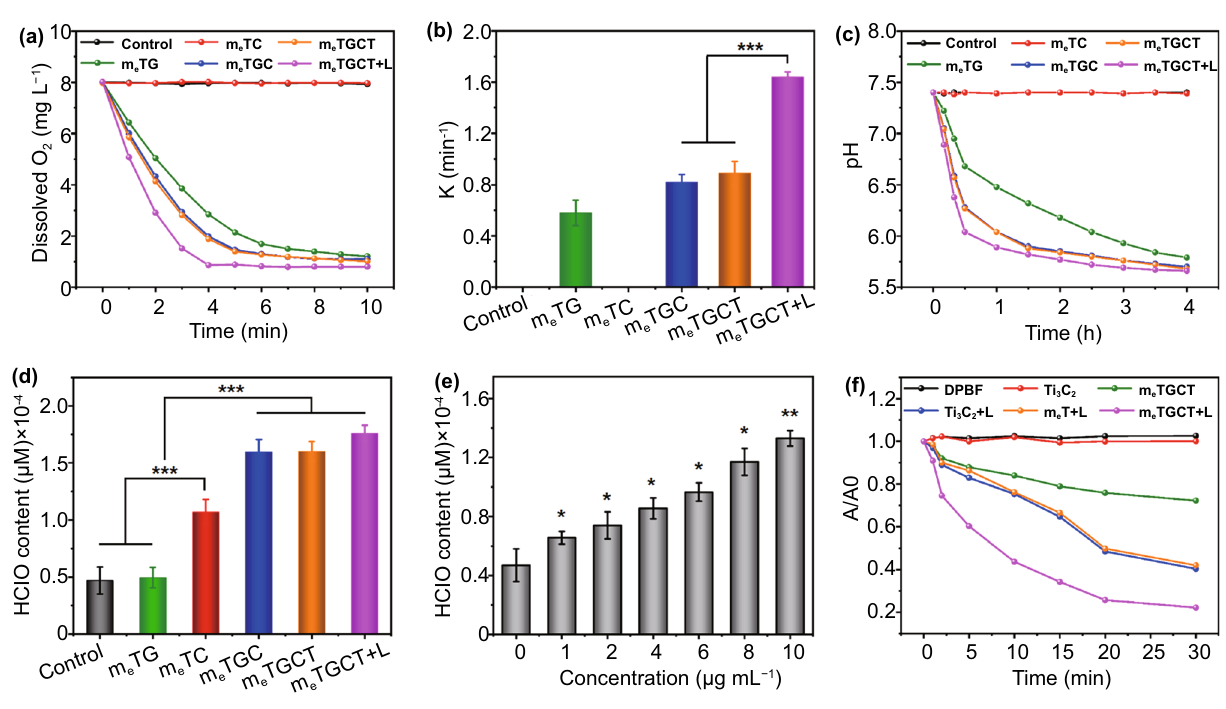
Fig. 3 a Changes of dissolved O 2 in PBS containing various samples with/without 635 nm (0.5 W cm −2 ) and 808 nm (1.5 W cm −2 ) lasers under 4 mg mL −1 of glucose and 25 mM of Cl − . b O 2 consumption rates based on a . c Changes of pH in PBS containing different samples. d HClO production content of PBS containing different samples. e HClO production content of PBS containing m e TGCT with different concentrations in the presence of 4 mg mL −1 of glucose and 25 mM of Cl − , p values were contrast with the group (concentration: 0 μg mL −1 ). f A/A0 of the DPBF treated with Ti 3 C 2 , m e T and m e TGCT with or without 635 nm light irradiation. ( ***p < 0.001, **p < 0.01, *p < 0.05, n =